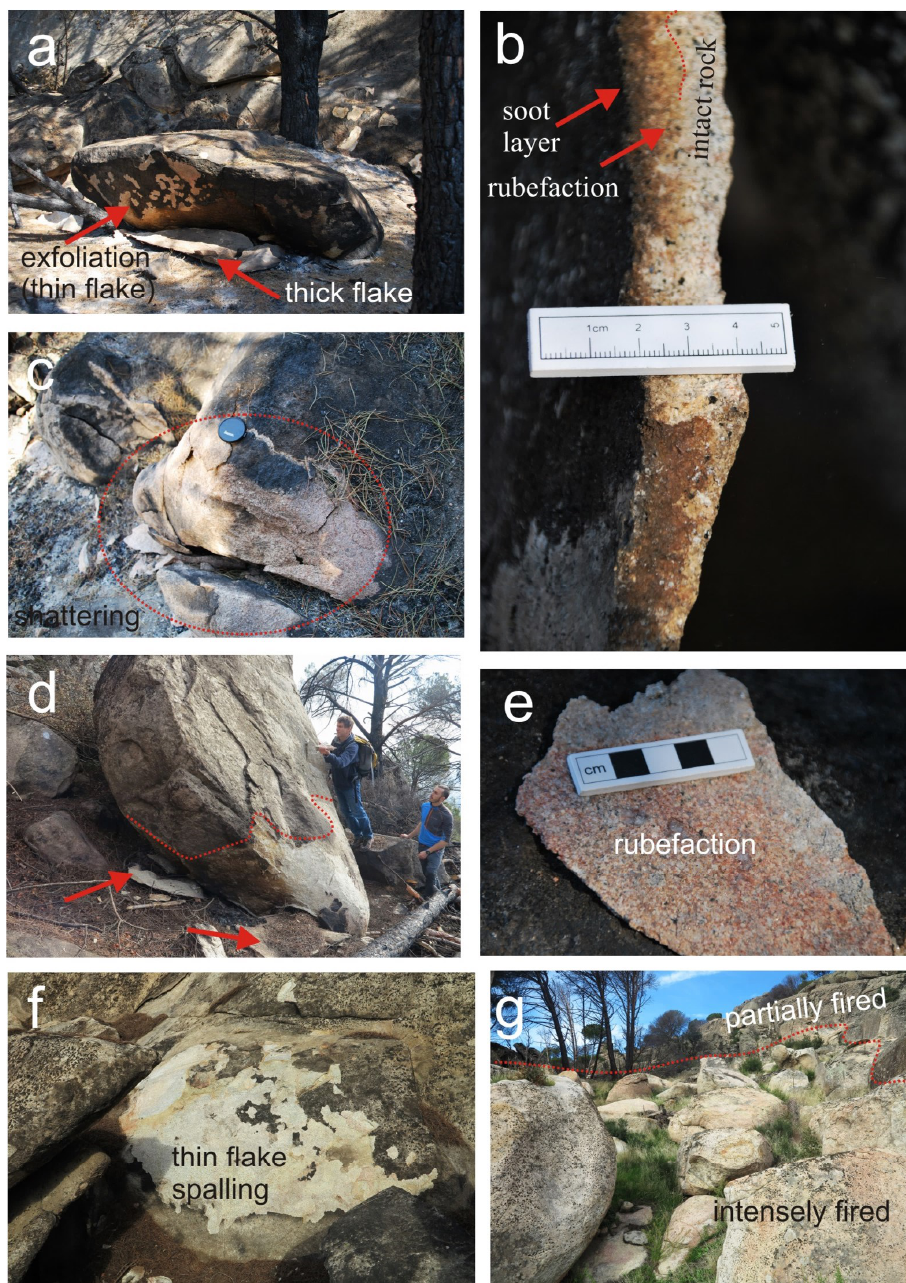
Figure 8. Visible rock surface decay features in the Cadalso de los Vidrios site as a result of the fire: ( a ) flaking of blackened surface and thick spalling at the bottom part of a boulder, possibly generated by thermal shock during aerial firefighting; ( b ) spall showing the surface black soot layer penetrating and clogging the fire-induced surface cracks, an intermediate thermally reddened portion, and seemingly unaffected rock; ( c ) completely shattered boulder as a consequence of intense thermal shock; ( d ) boulder showing a 1 m thick shattered portion at the bottom and spalling at the top, possibly due to prolonged heating caused by the burning of an adjacent log that appears to be completely burned; ( e ) reddened spall due to thermal oxidation of iron-rich micas; ( f ) boulder with extensive detached scaling and spalling, where a new “fresh” surface appears in the detached areas; ( g ) the clearer “fresh” surface formed after spalling is more abundant in areas that were totally covered by fire. Blackened surfaces of soot deposits appear in the area only partially affected by